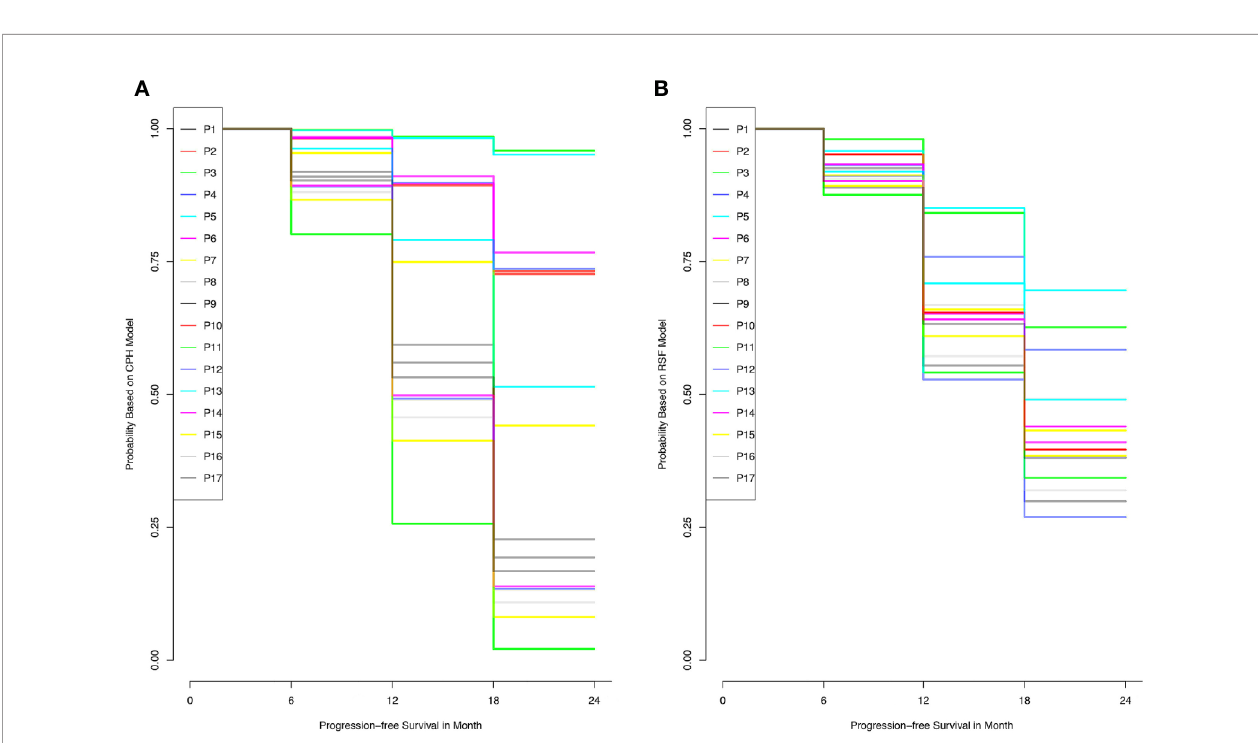
FIGURE 2 | Plots of concordance index (C-index) and brier score (BS) for comparing Cox proportional hazards (CPH) models and random survival forest (RSF) in the testing dataset. (A) Plot of C-index; (B) Plot of BS.